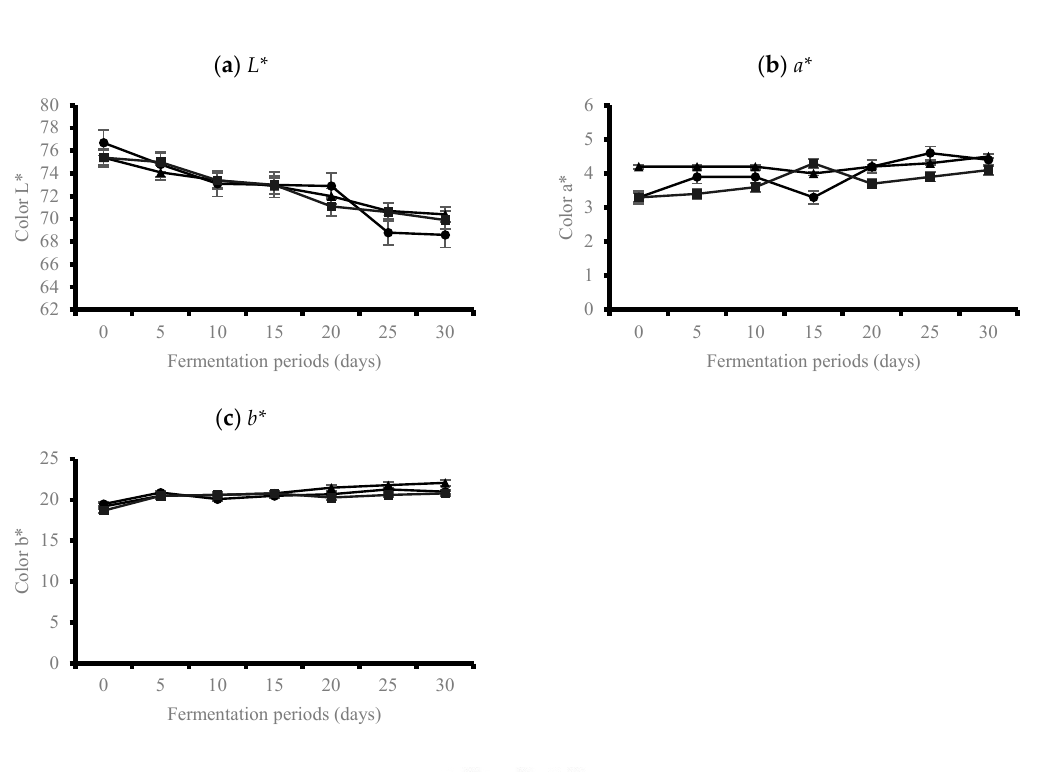
Foods 2021 , 10 , x FOR PEER REVIEW